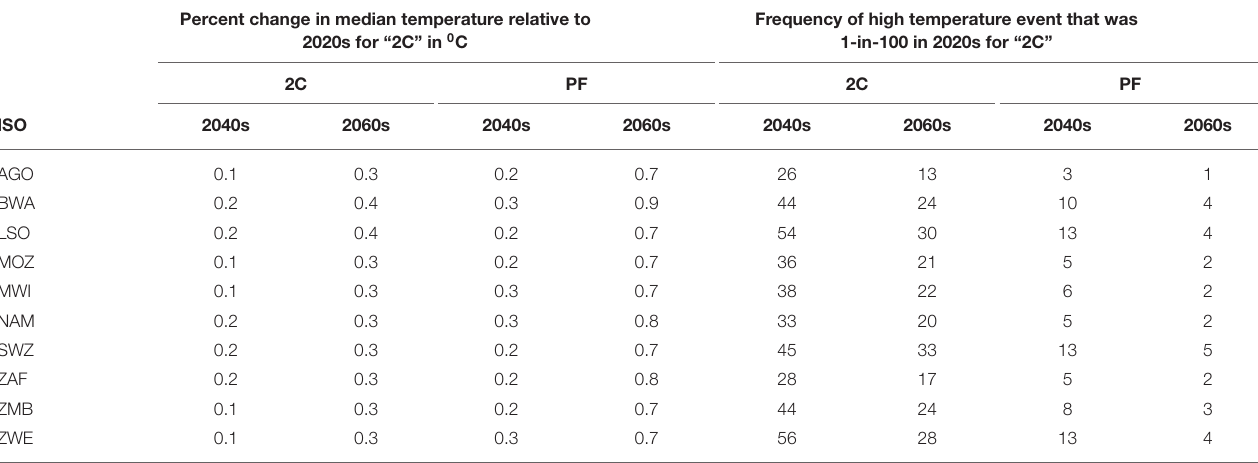
TABLE 4 | Change in frequency of very high temperature years for the wet 3 months of the year. Percent change in median temperature relative to Frequency of high temperature event that was 2020s for “2C” in 0 C 1-in-100 in 2020s for “2C” 2C PF